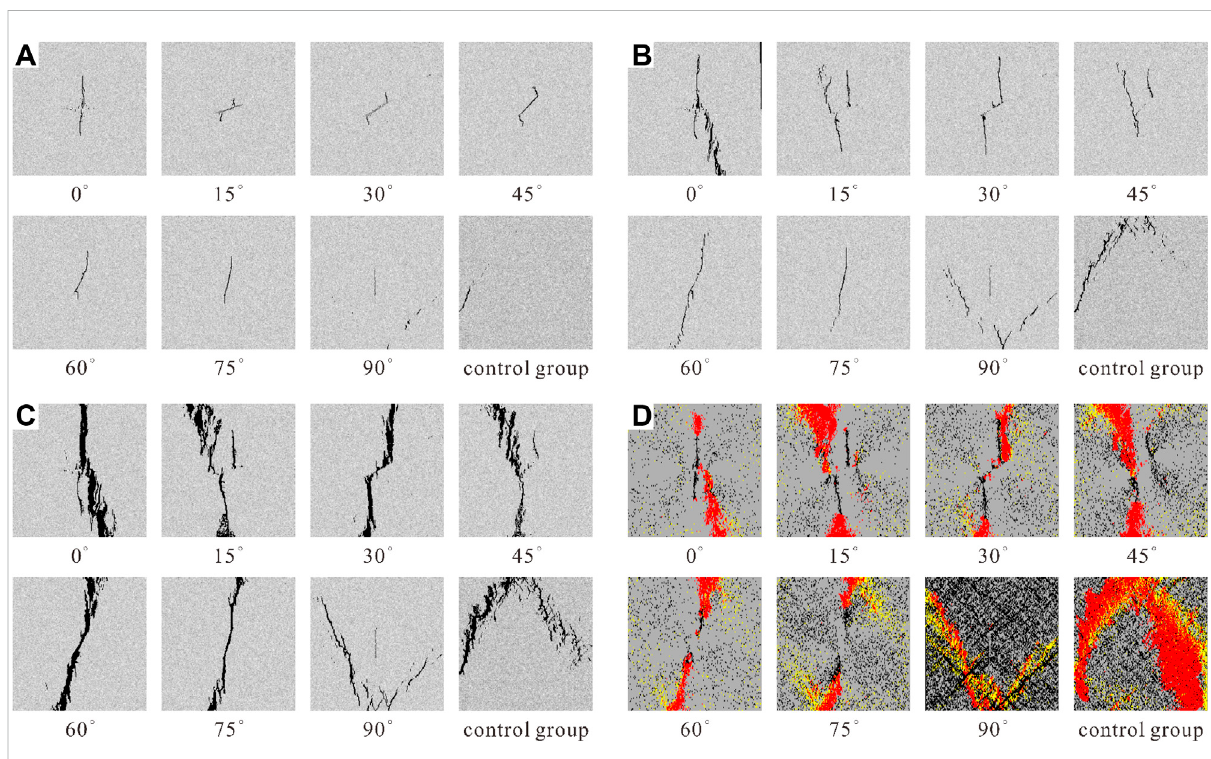
FIGURE 10 Fracturing process of microstructure of shale. (A) Crack initiation. (B) Crack propagation. (C) Fracture mode. (D) Acoustic